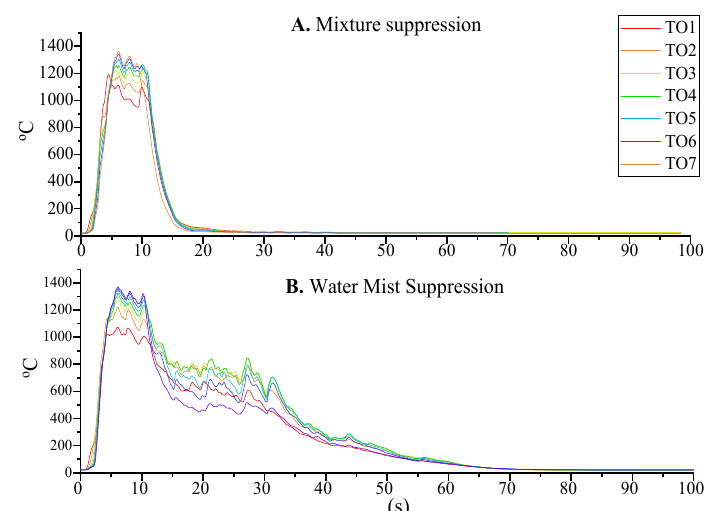
Figure 13. Temperature obtained by thermocouples below the nozzle during the process. ( a ) Suppression by mixture, ( b ) suppression by water droplets. Thermocouples at the center of the pool with z = 15, 30, 45, 60, 75, 90, 115 cm.